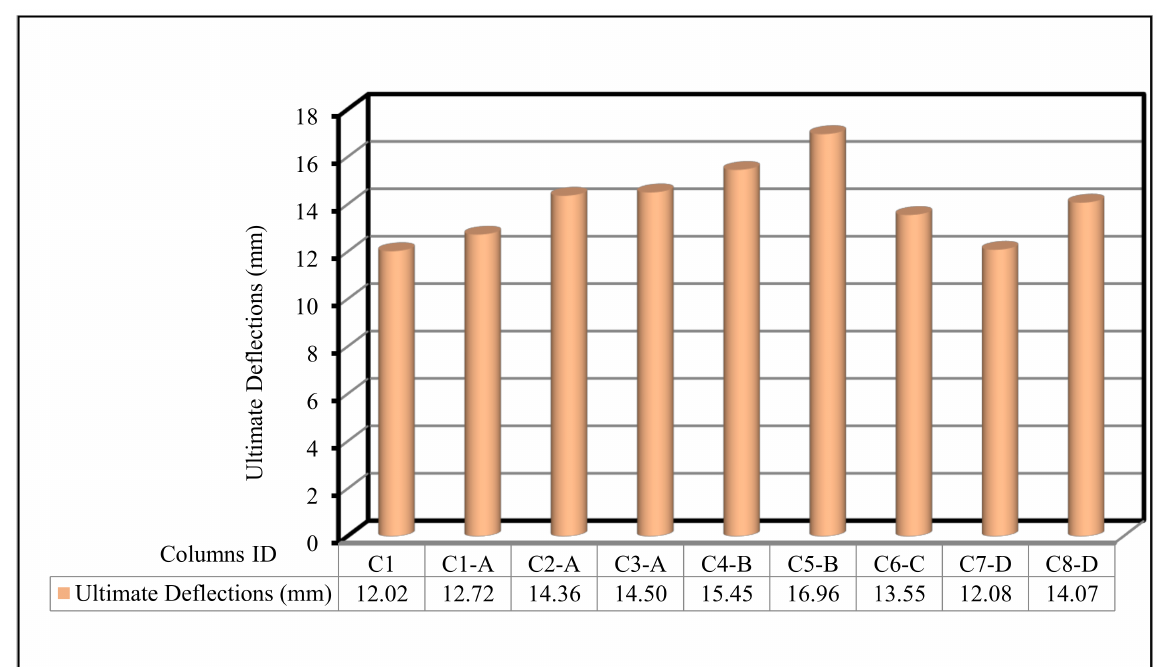
Figure 12. Ultimate deflection for the tested columns.